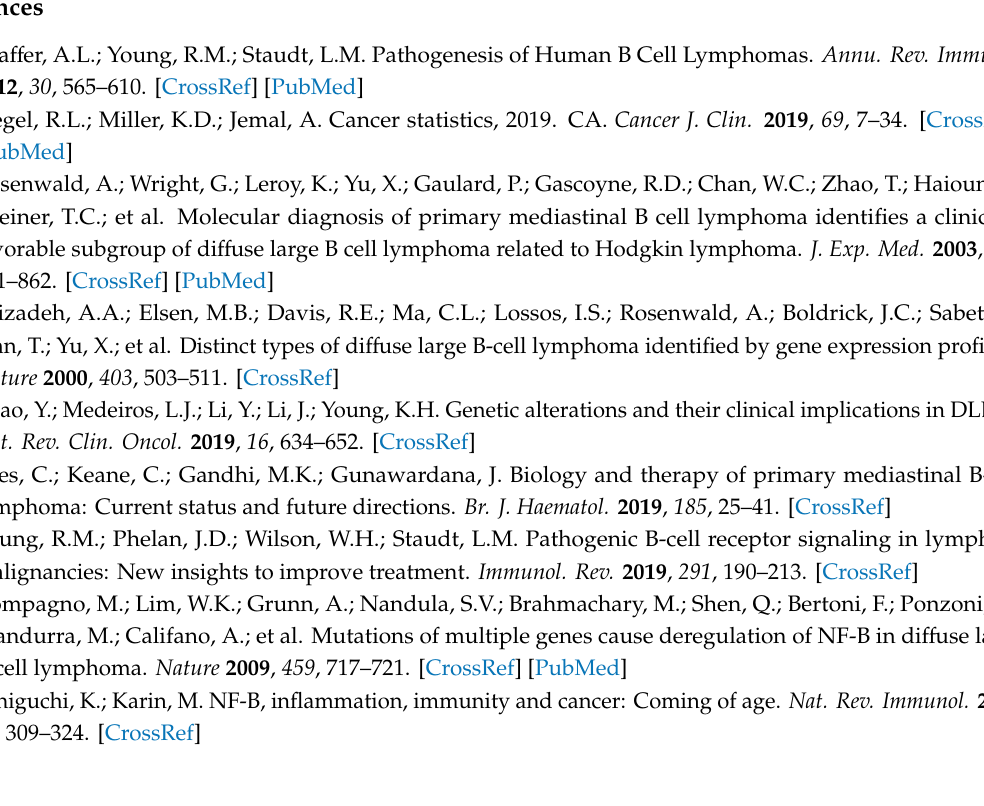
Figure S1: HEDO reduced the mitochondrial membrane potential within a short time in OCI-LY3 cells. Mitochondrial membrane potential of OCI-LY3 cells after 6 and 12 h loaded with TMRM (100 nM), as detected by flow cytometry, Figure S2: HEDO induced intracellular ROS levels within a short time in OCI-LY3 cells. Measurements of ROS levels in HEDO-treated OCI-LY3 cells after 6 and 12 h, as detected by flow cytometry with DCFDA (1 µ M), Figure S3: HEDO-induced apoptosis after 24 h and 48 h in OCI-LY3 cells. OCI-LY3 cells were untreated or treated with HEDO for 24 and 48 h. Afterwards, apoptosis evaluation was performed via Annexin V-APC / PI double staining and flow cytometry, Figure S4: Effects of HEDO on NF- κ B signaling in OCI-LY3 cells. Whole cell lysates were used to determine the expression levels of phosphorylated-I kappa B alpha (p-I κ B α ) and I κ B α after treating the cells with HEDO, Figure S5: HEDO induced mitochondrial ROS levels in OCI-LY3 cells. (A) Measurements of mitochondrial ROS levels in HEDO-treated OCI-LY3 cells after 24 h, as detected by flow cytometry with MitoSOX (5 µ M). (B) Quantified mitochondrial ROS levels. Values indicate the means ± SEM. (n = 3, * p < 0.05, *** p ≤ 0.001), Figure S6: Mitochondrial membrane potential changes induced by HEDO in OCI-LY3 cells. (A) Measurements of mitochondrial membrane potential in HEDO-treated OCI-LY3 cells after 24 h, as detected by flow cytometry with JC-1 (2 µ M). (B) Quantified mitochondrial ROS levels, Figure S7: Effect of HEDO on the mRNA expression levels of involved antioxidants in OCI-LY3 cells. The qRT-PCR analysis results of the mRNA levels of SOD1, GPx, and CAT in the control and the HEDO (10 µ M)-treated OCI-LY3 cells (n = 3, *** p ≤ 0.001) were